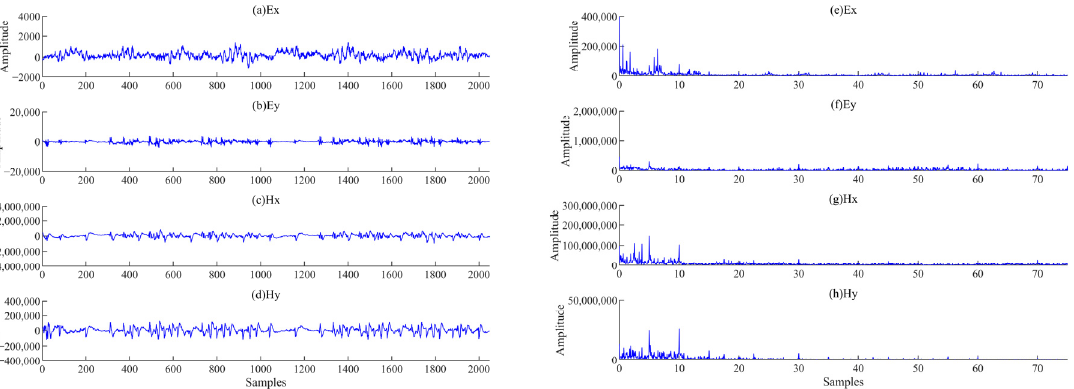
Figure 16. The time-series segments denoised by DRSN. Time domain waveform of ( a ) Ex component; ( b ) Ey component; ( c ) Hx component; ( d ) Hy component. The left panels are time domain waveforms, and the right panels are their spectra. Spectrum of ( e ) Ex component; ( f ) Ey component; ( g ) Hx component; ( h ) Hy component.